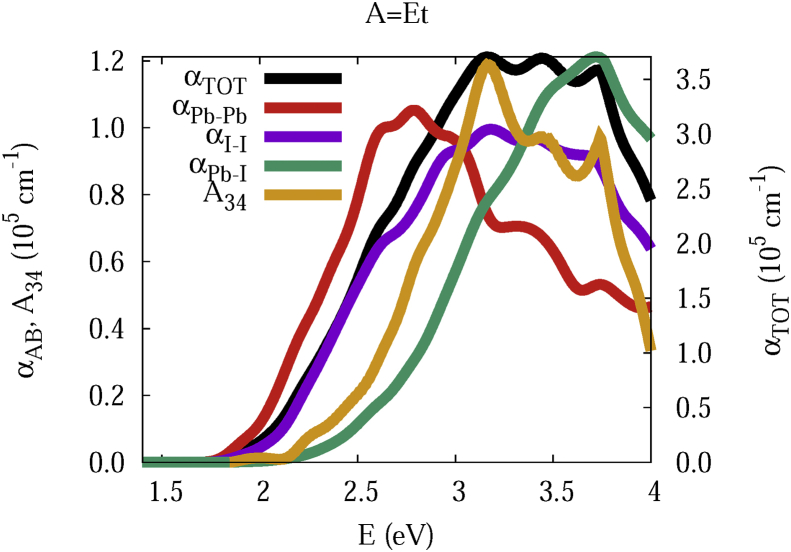
Same legend as that in Fig. 1, but for A = Et.